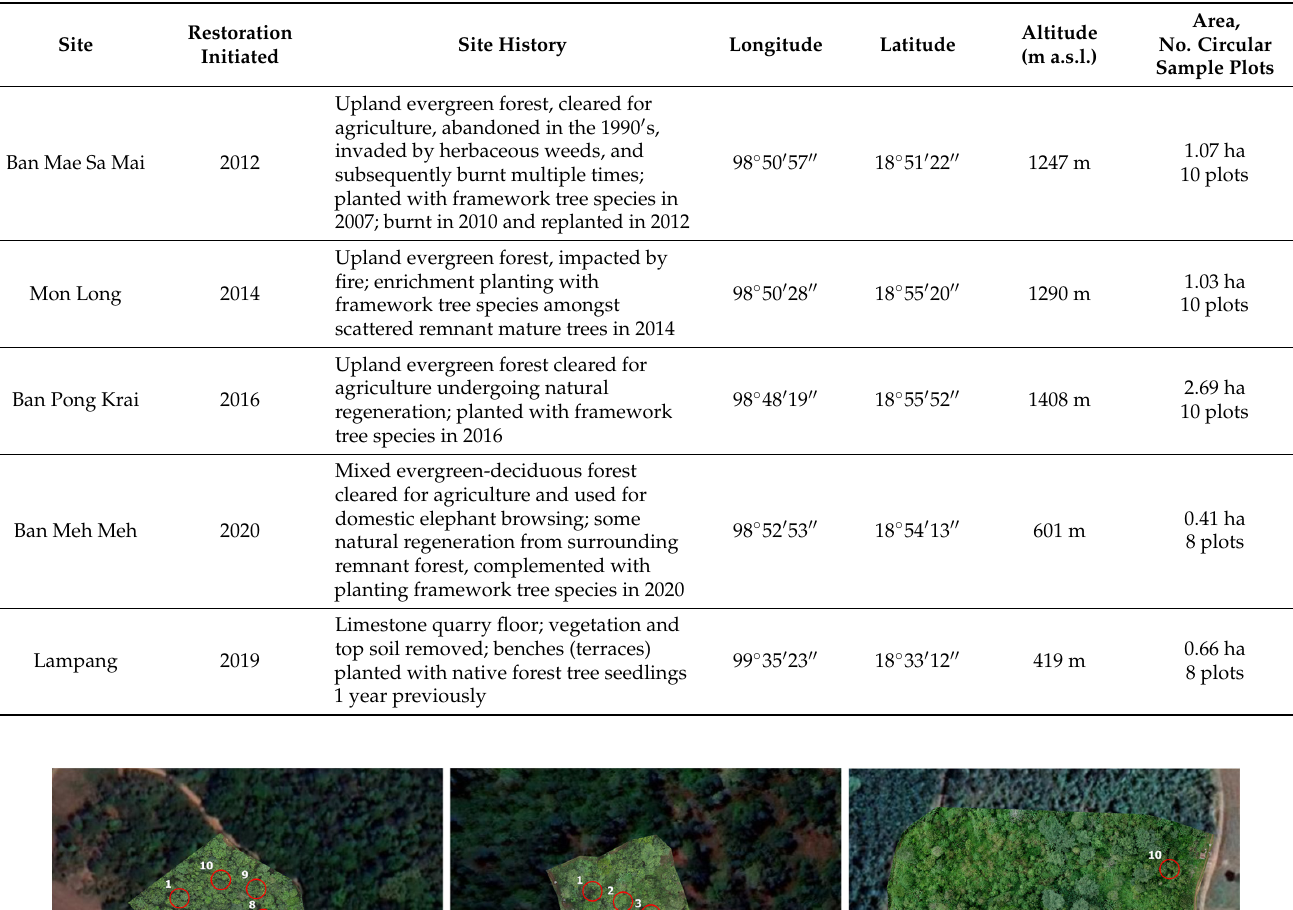
Table 1. Details of the 5 study sites in northern Thailand.